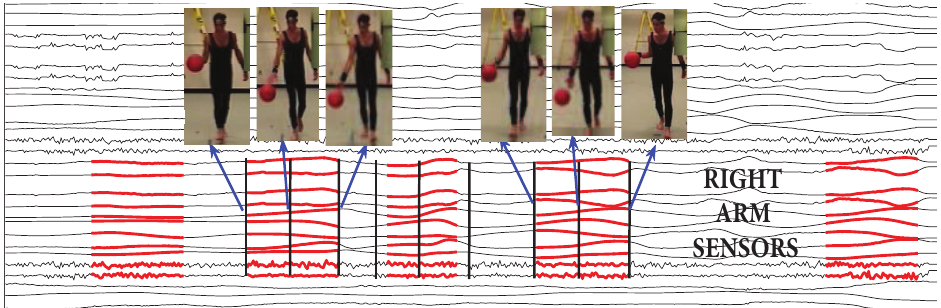
Figure 1. In this motion capture snippet (from MoCap [10]), the repeated pattern (dribble action) is focused on the sensors corresponding to the right arm; note that not all dribble actions were performed at the same speed.